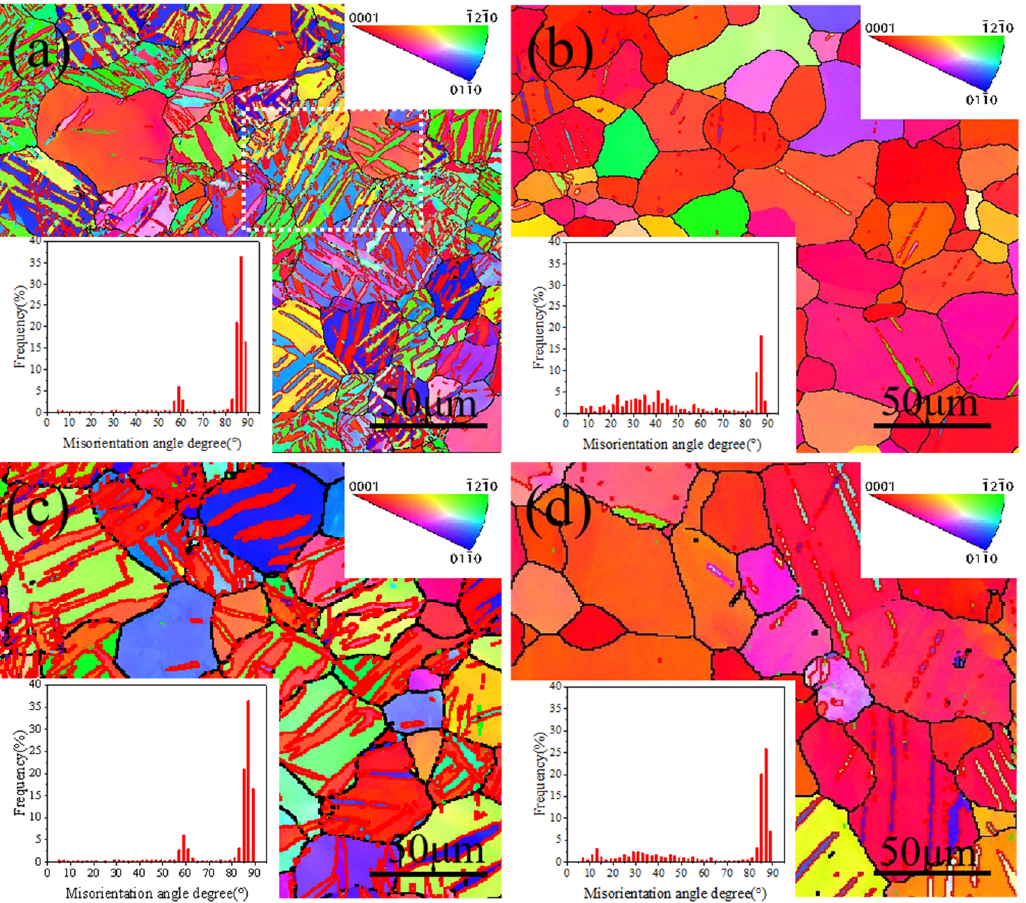
Figure 3. EBSD maps of different samples: ( a ) strain amplitude of 1% along ND; ( b ) strain amplitude of 0.5% along ND; ( c ) strain amplitude of 1% along RD; ( d ) strain amplitude of 0.5% along RD. The boundaries of {1012} twins are colored in red.